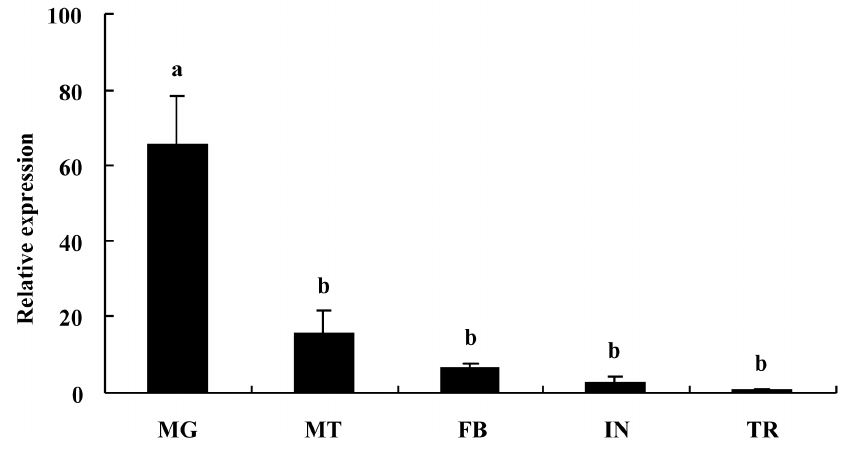
Figure 3. Expression profiles of the BdCHS2 in different tissues of larval Bactrocera dorsalis. The tissues include integument (IN), fat body (FB), midgut (MG), Malpighian tubules (MT), and trachea (TR). α -Tubulin was used as an internal reference gene. The relative expression was calculated based on the value of the lowest expression, which was ascribed an arbitrary value of 1. Data are means ± SE of three biological